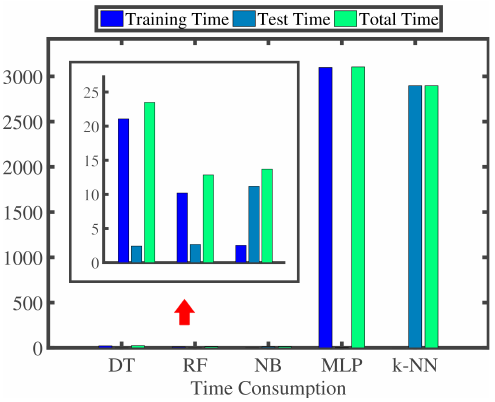
Figure 22. Total time consumed by different recognition